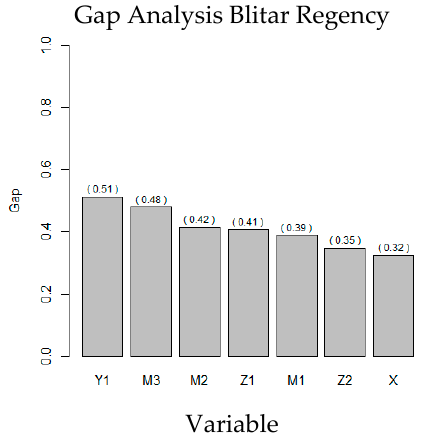
J. Open Innov. Technol. Mark. Complex. 2020 , 6 , x FOR PEER REVIEW Figure A8. Bar Diagram of Gap Analysis of Kediri City. Figure A8. Bar Diagram of Gap Analysis of Kediri City.